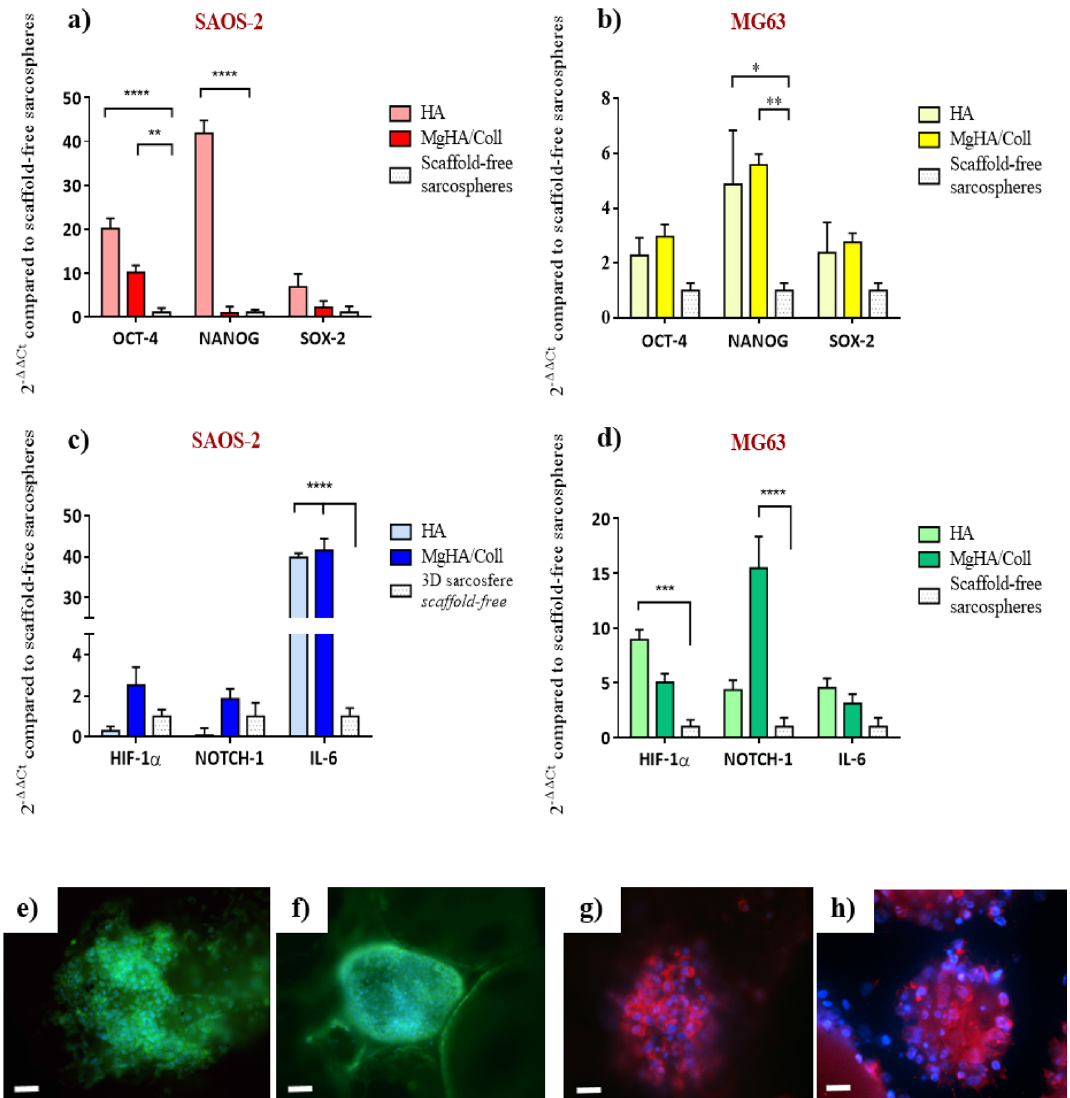
( b ). Relative quantification of HIF-1a, NOTCH-1 and IL-6, CSCs niche-related genes, SAOS-2 ( c ) and MG63 ( d ). The graphs show the fold change expression of the genes relative to the scaffold-free sarcospheres at day 10 of culture (mean ± standard error; * p value ≤ 0.05; ** p value ≤ 0.01; *** p value ≤ 0.001; **** p value ≤ 0.0001;). The panel shows a representative image of OCT-4 immunolocalization in SAOS-2 sarcorpheres MgHA/Coll model ( e ) and in HA model ( f ) scale bar 50 µm; SOX-2 immunolocalization in MG63 sarcorpheres MgHA/Coll model ( g ) and in HA model ( h ) scale bar 25 µm. Blu: cell nuclei; green: OCT-4; red: